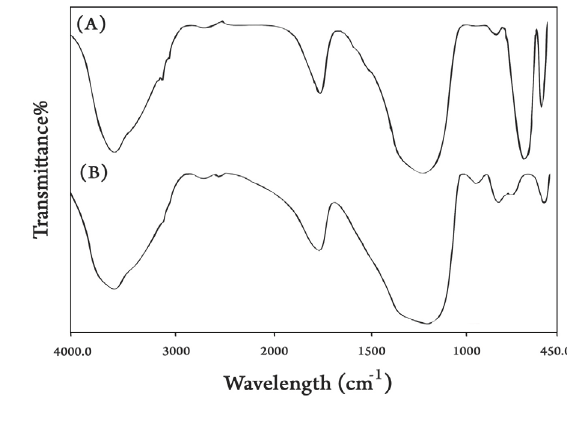
Table 2: ANOVA Analysis of